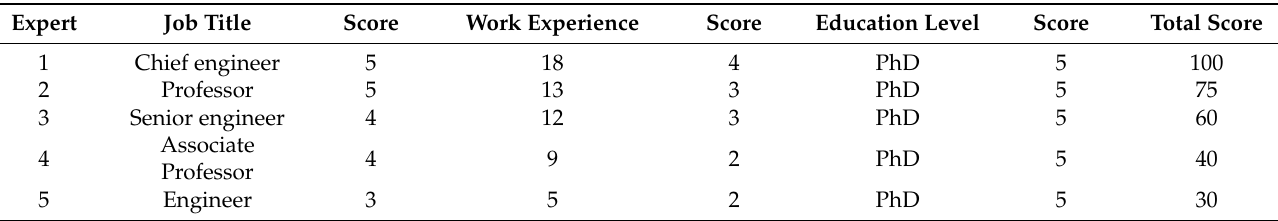
Table 10. The scores of expert importance.